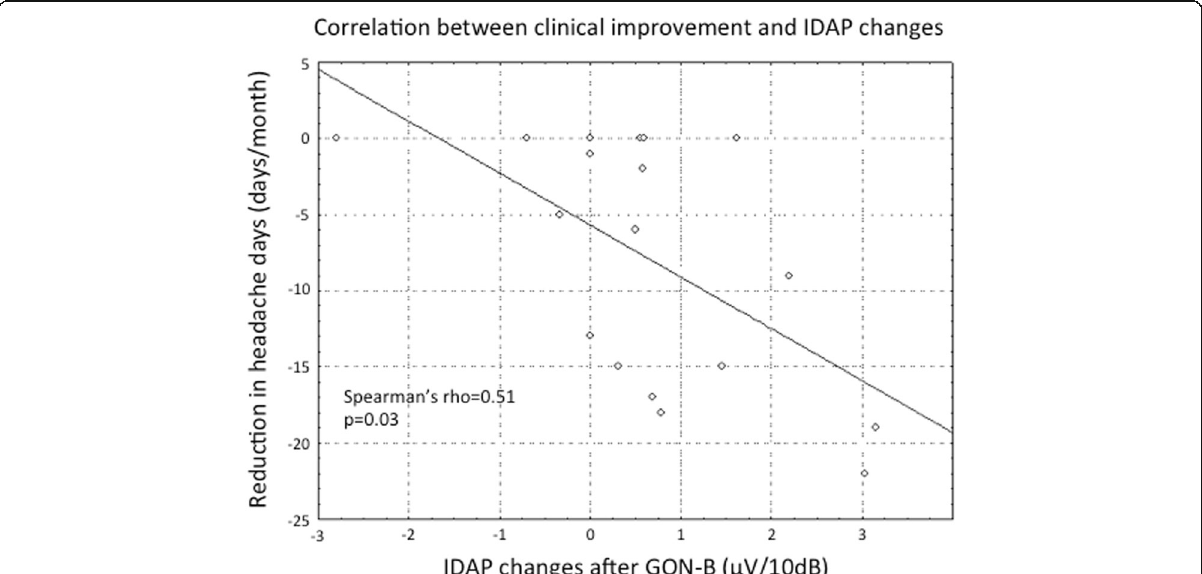
Fig. 4 Correlation analysis between clinical improvement and IDAP changes. At the group level, the reduction in IDAP value was positively correlated with the reduction of day of headache in the follow-up month. Positive IDAP values indicate that the T1 measurement was smaller than the first. The calculation for IDAP change was: IDAP change = IDAP(T0)-IDAP(T1). On the other hand for headache days calculation was: Headache reduction =